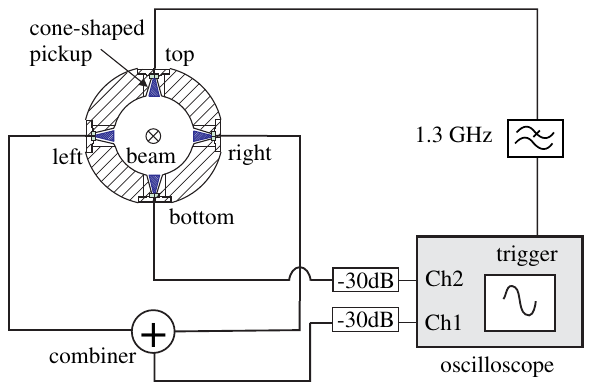
FIG. 1. Measurement setup with the cone-shaped pickups at FLASH. The left and the right pickup are combined and connected to the oscilloscope channel 1, the bottom pickup is connected to channel 2 and the top pickup is used as a